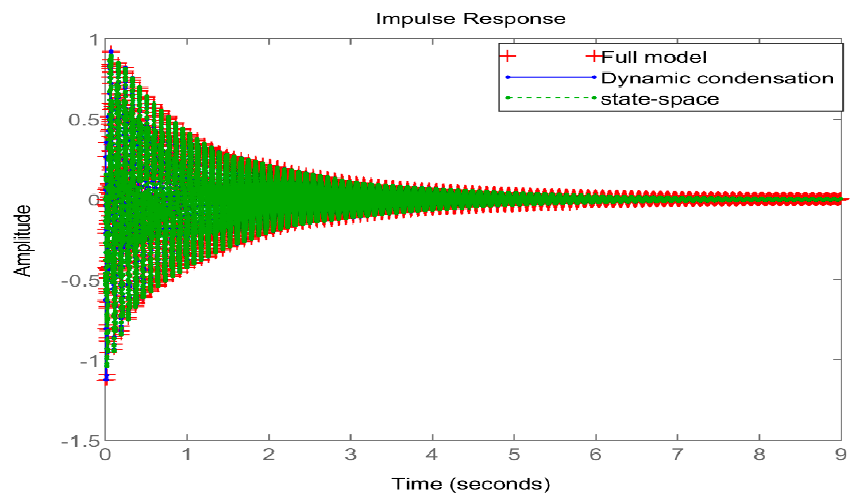
Figure 10. Comparison of time–domain impulse response diagrams before and after order reduc- tion.